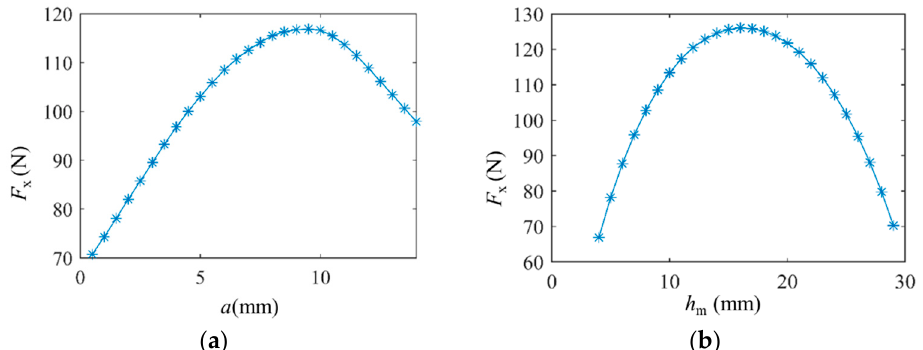
Figure 5. Relationship between electromagnetic force and permanent magnet width ( a ), and height ( b ) at J = 13.33A/mm 2 .